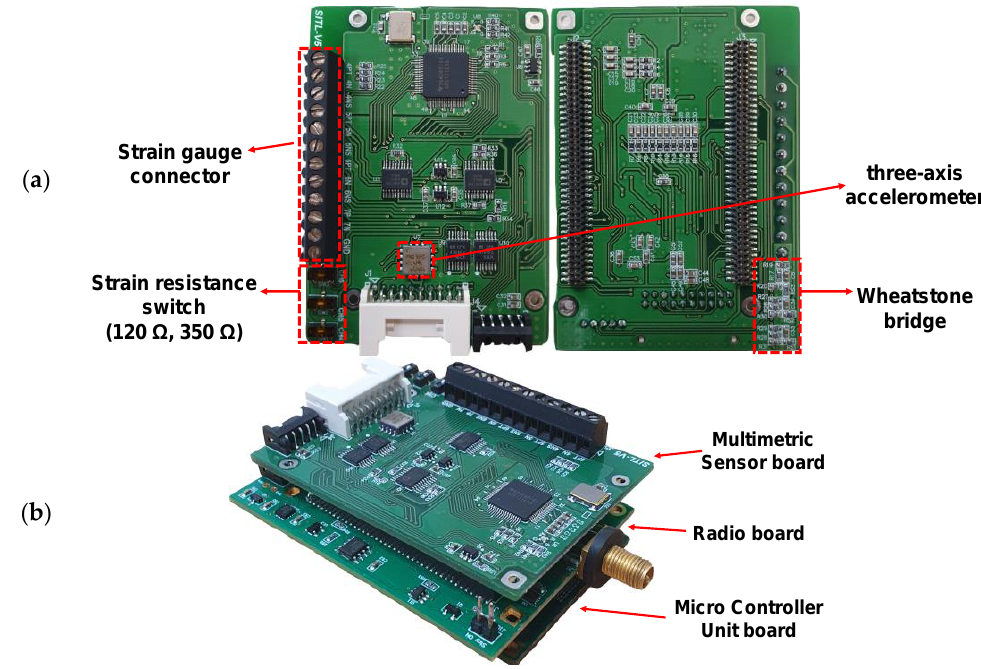
Figure 4. ( a ) Developed multimetric sensor board and ( b ) its integration with Xnode.